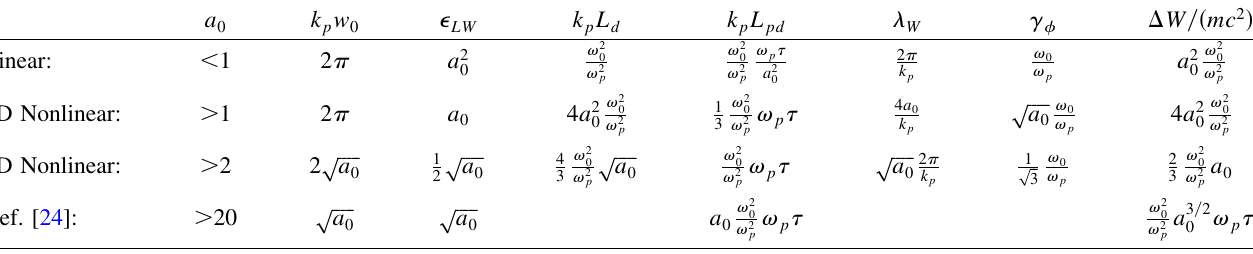
TABLE I. This table compares formulas and scalings from linear theory, 1D nonlinear theory, the similarity theory of Ref. [24] and shows the range of a that each theory is intended for. the 3D phenomenological nonlinear theory in this paper. The column labeled a 0 0 w w k from linear and 1D nonlinear theory is kept constant while in both our theory and the theory of Ref. [24]. k scales with the p p 0 0 blowout radius. The acceleration length is limited by dephasing in linear theory and our 3D nonlinear theory, while it is limited by pump depletion in 1D nonlinear theory and the work of GP. (Note that in standard 1D nonlinear theory the phase velocity of the wake is incorrectly set equal to the nonlinear group velocity.) Only in our 3D nonlinear theory do dephasing and pump depletion scale the same way (if the pulse length is matched to the blowout radius). The dephasing length is evidently ignored in Ref. [24] so the energy gain depends on the pulse length. Linear dephasing and 1D nonlinear dephasing both scale differently than in the 3D nonlinear regime. The pump depletion length from 1D nonlinear theory scales as in 3D nonlinear theory but for different physics reasons. In 1D, all of the laser energy goes into the wake while in our 3D theory this is not the case. We discuss the pump depletion length from Ref. [24] extensively in the text. Both linear and 1D nonlinear theory incorrectly identify the plasma wavelength and wake phase velocity. The p (cid:1) (cid:11) (cid:1)(cid:1)(cid:1)(cid:1)(cid:1) a . Therefore linear, 1D nonlinear, in Ref. [24], then the energy scales as a 2 resulting energy scalings are different. If one sets ! p 0 0 and the similarity theory of Ref. [24] all give identical scalings for the (cid:1) W with both intensity and density while in the regime to the first presented here (cid:1) W scales as a 0